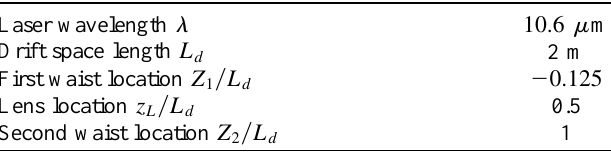
TABLE II. Beam optics in the buncher of STELLA. Laser wavelength l